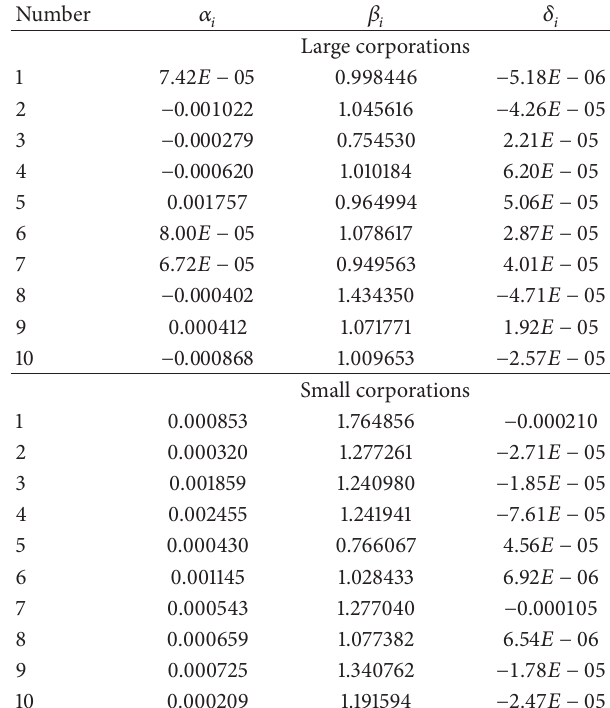
Table 3: Results of Censored-SS